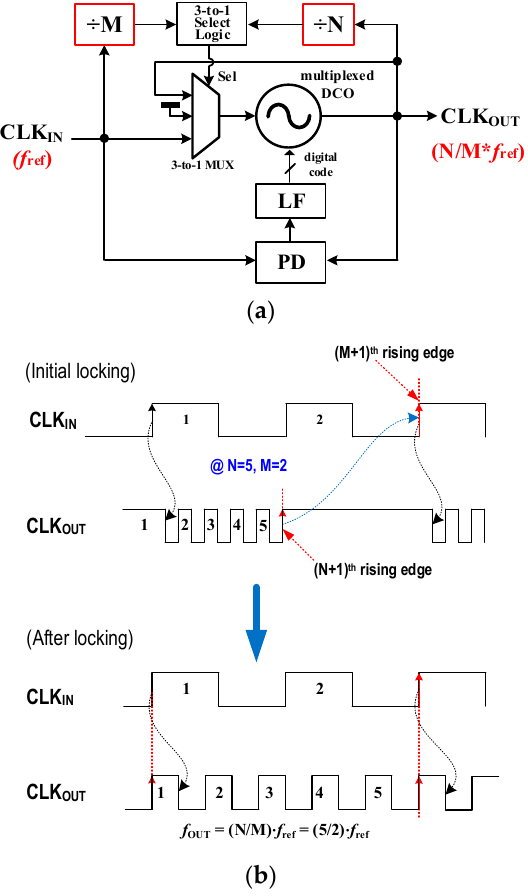
Figure 3. ( a ) Block diagram of a de-skewed N/M-ratio MDLL architecture [10]. ( b ) Locking process when N/M = 5/2.